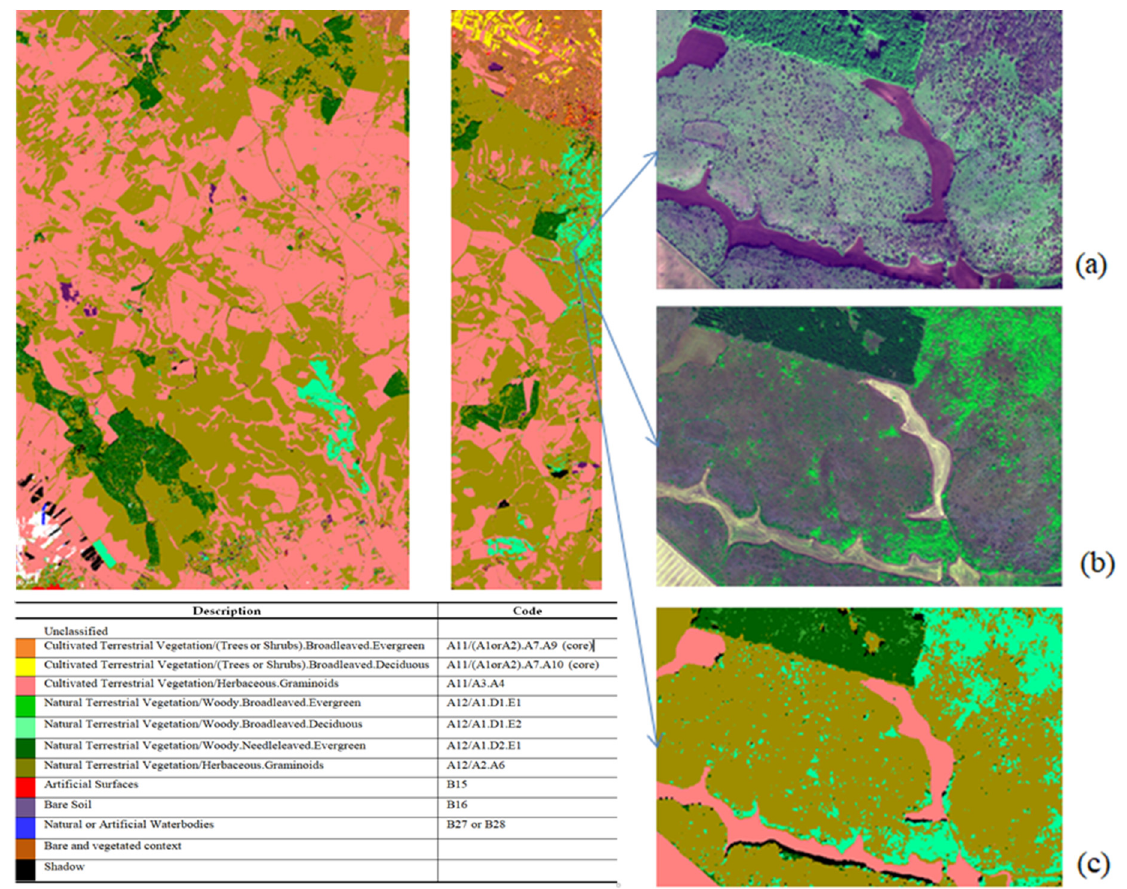
Figure 9. Close-ups of Murgia Alta SO output map at LCCS Level 4. Area in the black box: ( a ) pre-peak of biomass (PrePoB) image, ( b ) dry season (DS) image, ( c ) SO map.